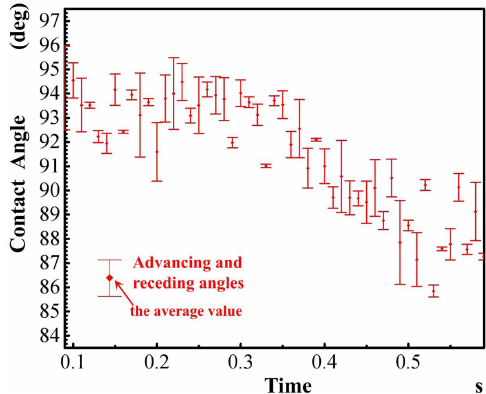
Figure 6. The CA variation from 0 s to 0.6 s during the ultrasonic exciting period, each two adjacent data share with 0.01 s time interval. Error bars are attached to ultrasonical CA on according to the “swaying